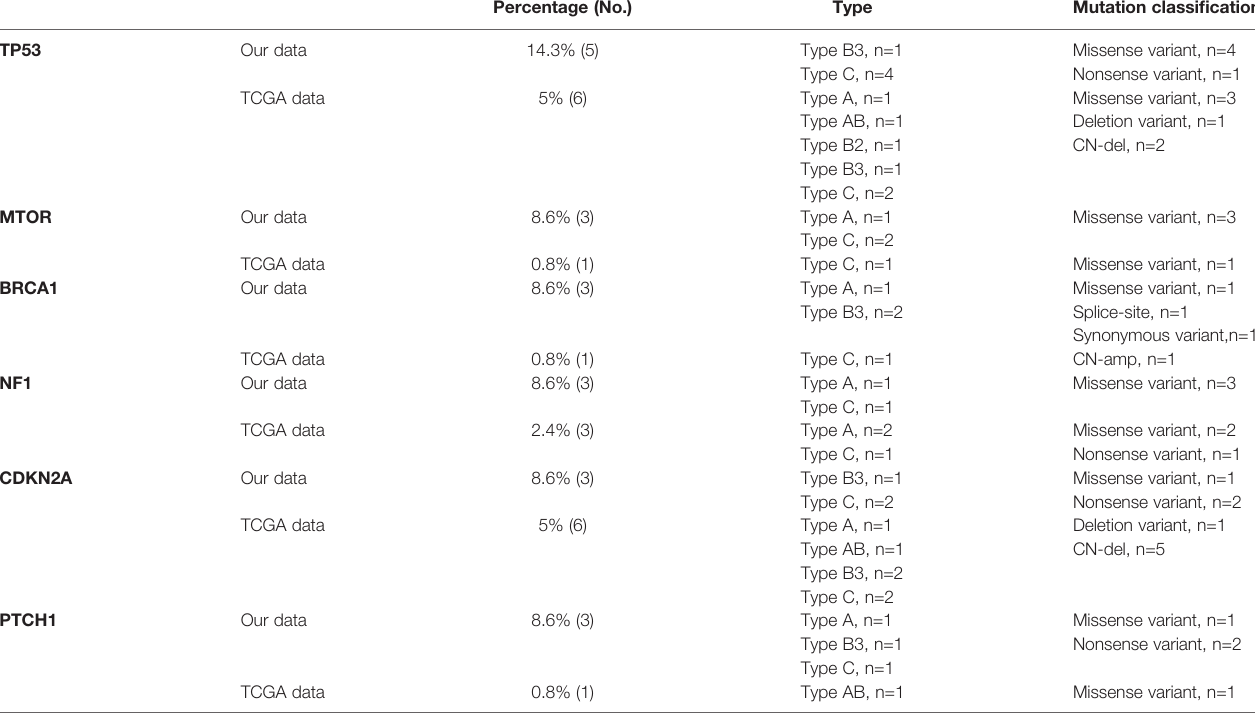
TABLE 2 | Thymic epithelial tumor patients with high frequent gene alterations (somatic mutation and copy number alterations) in our cohort and TCGA data. Percentage